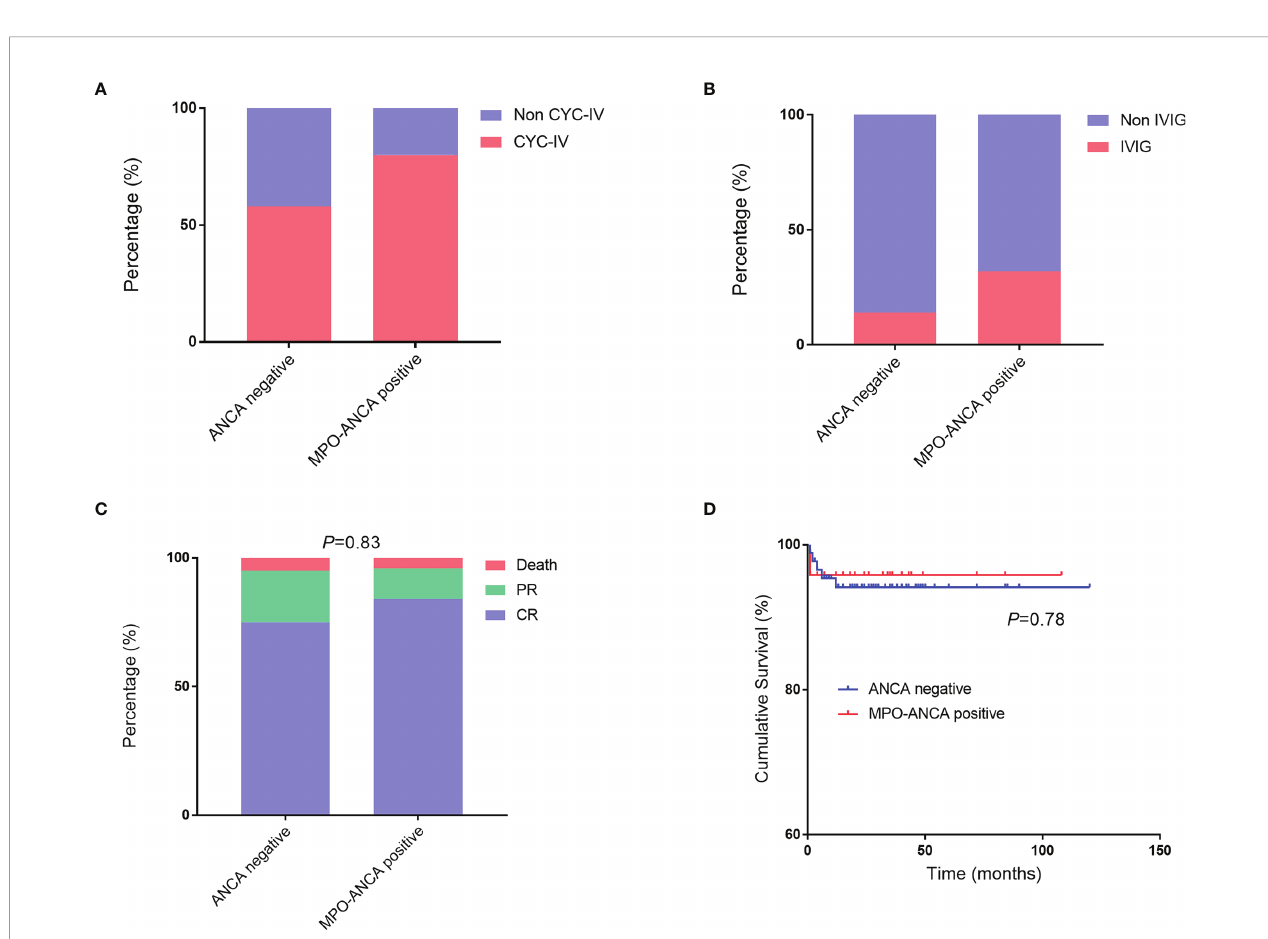
FIGURE 3 | Treatment and outcomes in patients with EGPA with MPO-ANCA and without ANCA. (A, B) Comparisons of CYC-IV and IVIG used in patients with MPO-ANCA and without ANCA. (C, D) Comparisons of outcomes and cumulative survival rates between the two groups. ANCA, antineutrophil cytoplasmic antibody; CYC-IV, intravenous cyclophosphamide; EGPA, eosinophilic granulomatosis with polyangiitis; IVIG, intravenous immunoglobulin; MPO,